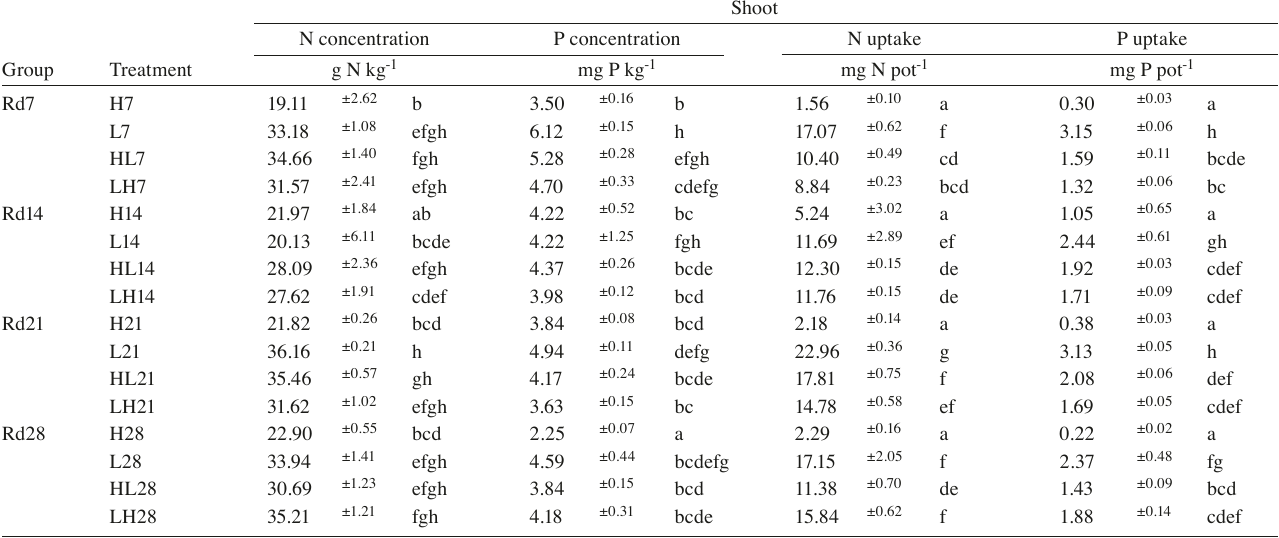
Tab. 4: Shoot and root N and P concentration (g kg -1 ) and uptake (mg pot -1 ) of wheat 28 days after the second residue addition in treatments with only high C/N residue added (H), only low C/N residue added (L), high followed by low C/N (HL) or low followed by high (LH) where the second residue was added 7, 14, 21 or 28 days after the first (Rd7, Rd14, Rd21, Rd28) (n=4 ± standard error ). Values followed by different letters are significantly different (P≤ 0.05).